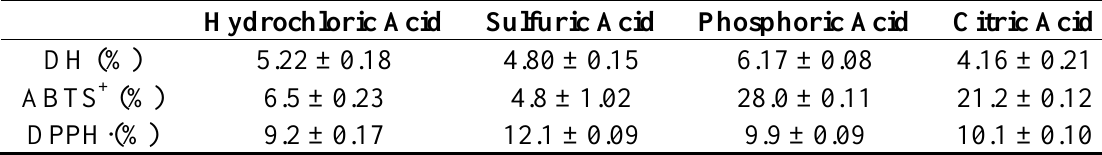
Table 1. Comparison of acids used for microwave-assisted